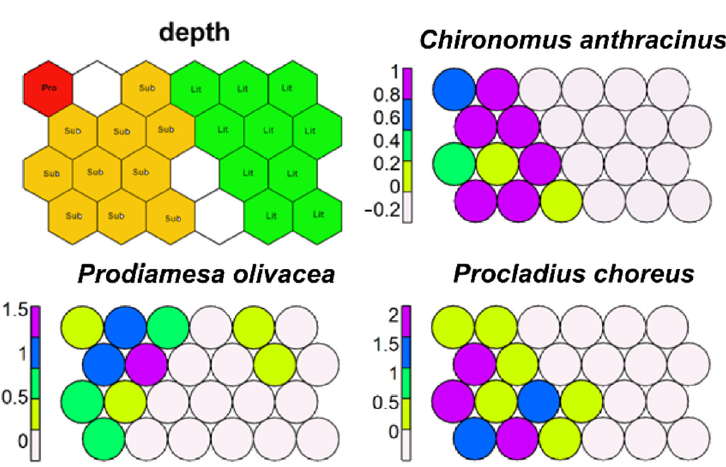
Figure 14. Supervised map of sites and three morphotaxa clustered using depth zone as external factor. Running waters and lake littorals (lit, green), lake sublittorals (sub, orange), and lake profundals (pro, red).